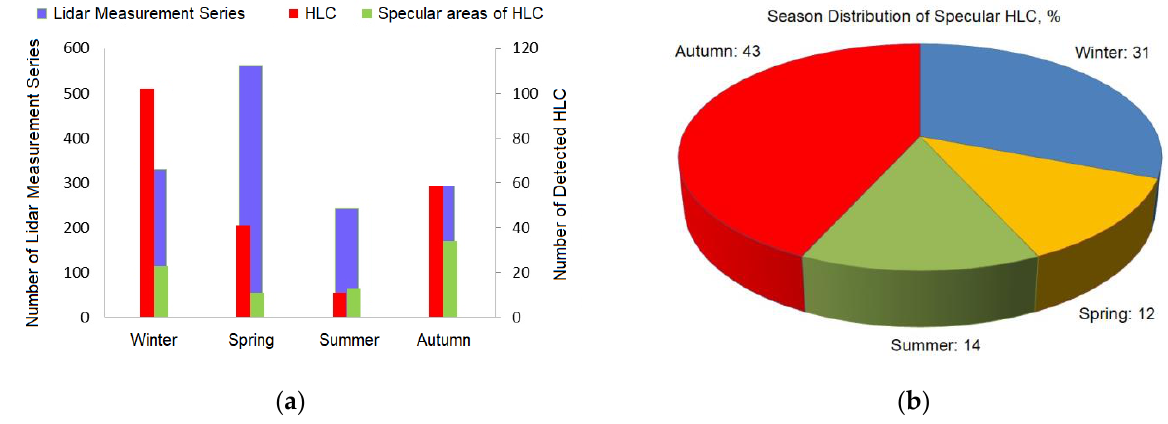
Figure 4. Vertical profiles of temperature ( a ) and wind direction ( b ) from data of the radiosonde observations (RAOB) and reanalysis (ERA5) for the Kolpashevo, Novosibirsk and Tomsk coordi- nates.